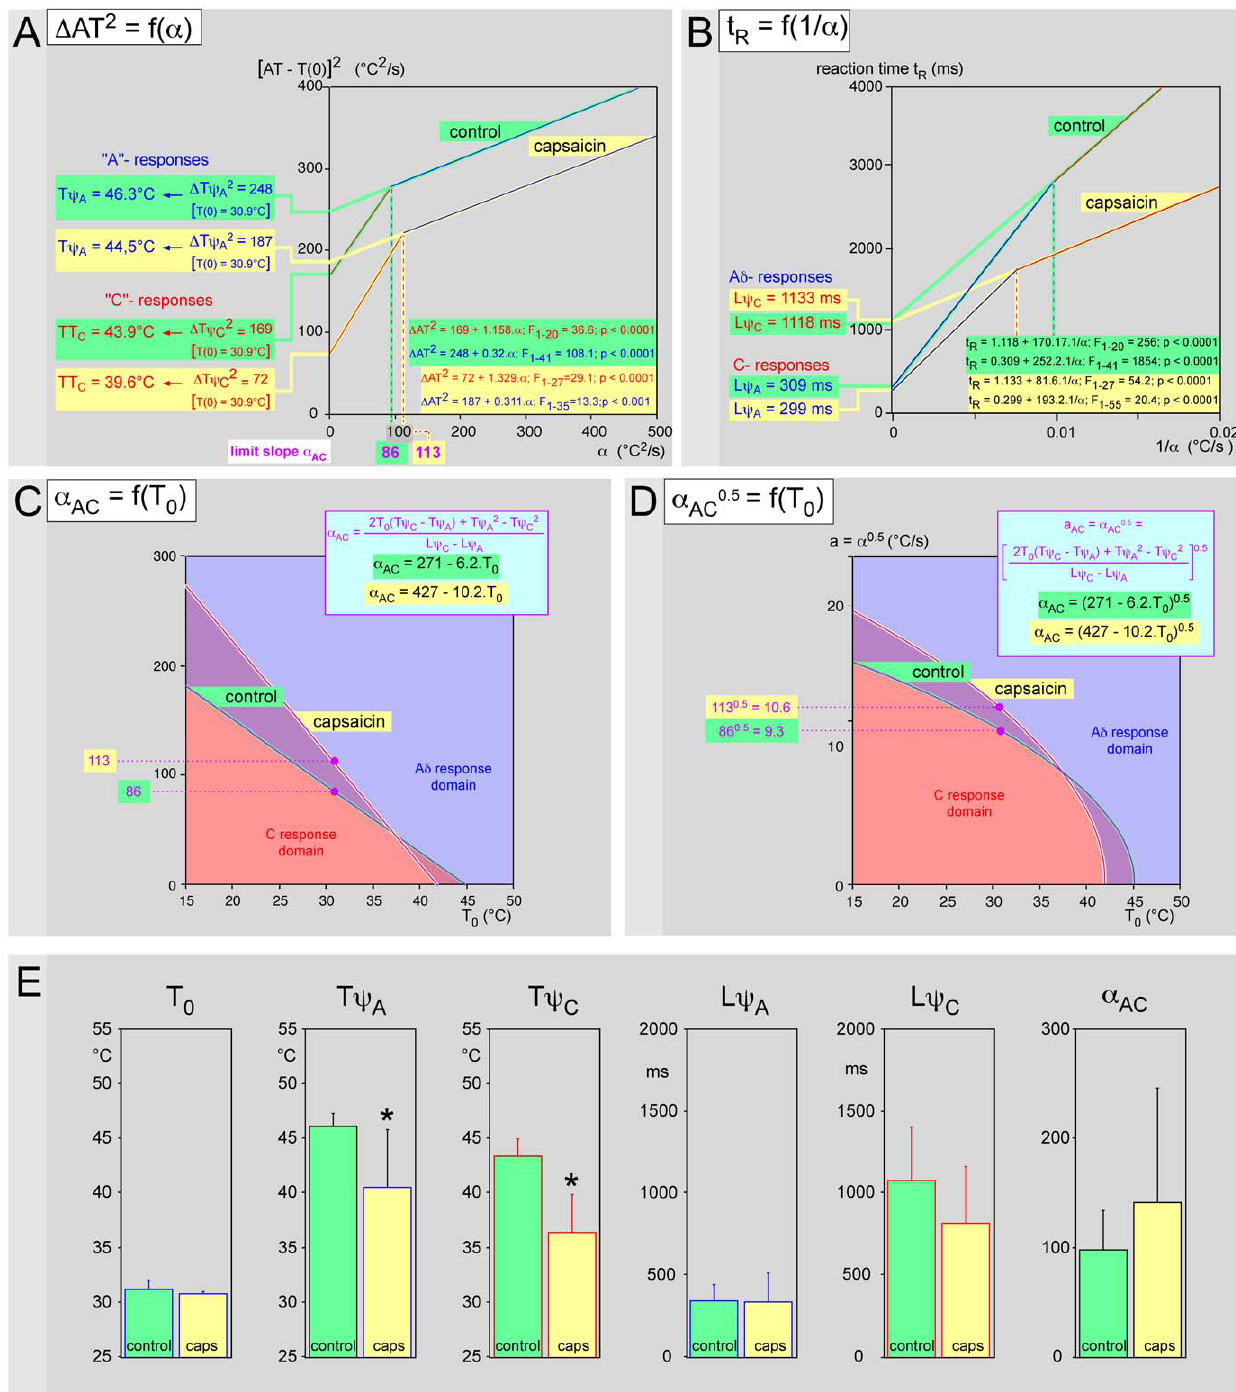
Figure 10. Effects of capsaicin. Presentation as in Fig. 9 (ABCD: individual example, E global data). - A Capsaicin elicited a downward shift of the straight lines D AT 2 =(AT 2 T 0 ) 2 =f( a ) and consequently a reduction of T y A ( 2 2.4 u C) and T y C ( 2 4.9 u C) thresholds because the base temperature T 0 varied little. - B These effects resulted in corresponding variations of the slopes of the straight lines t R =f(1/ a ) without modification of the intercept with the ordinate, indicating that the psychophysical latencies were not modified by the treatment. - C & - D All these modifications were responsible for a shift of the respective domains of A d - and C- fibers to the advantage of the former and the latter for T 0 below and above 39 u C, respectively. The white lines exemplify a hypothetical case where the sensation in triggered by A d -fibers in the control situation and by C-fibers following capsaicin (see discussion). - E . Overall mean results regarding physical (T 0 ) and psychophysical (T y A , T y C , L y A , L y C and a AC ) variables (*=p , 0.05; Wilcoxon-Mann-Whitney test).